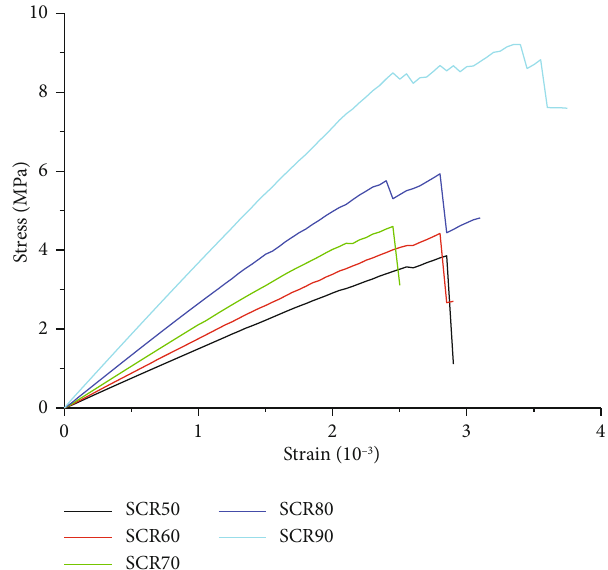
Figure 7: Stress-strain curves of samples with di ff erent coal-to- rock height ratios after adding water pressure.